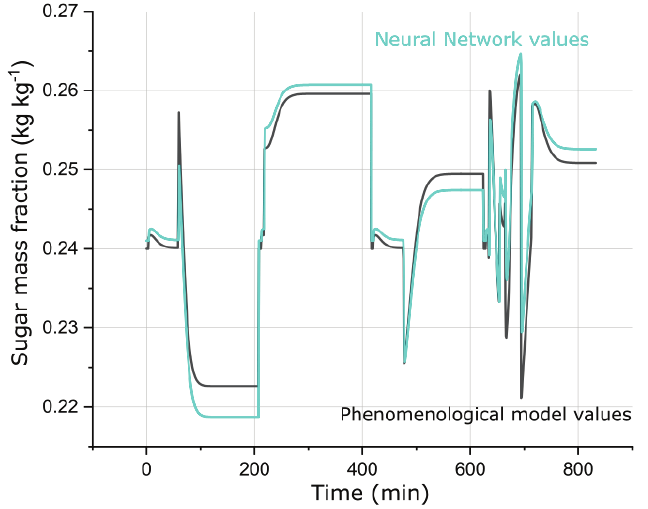
Fig. 4 – Neural network performance in comparison with values generated by the phenomenological